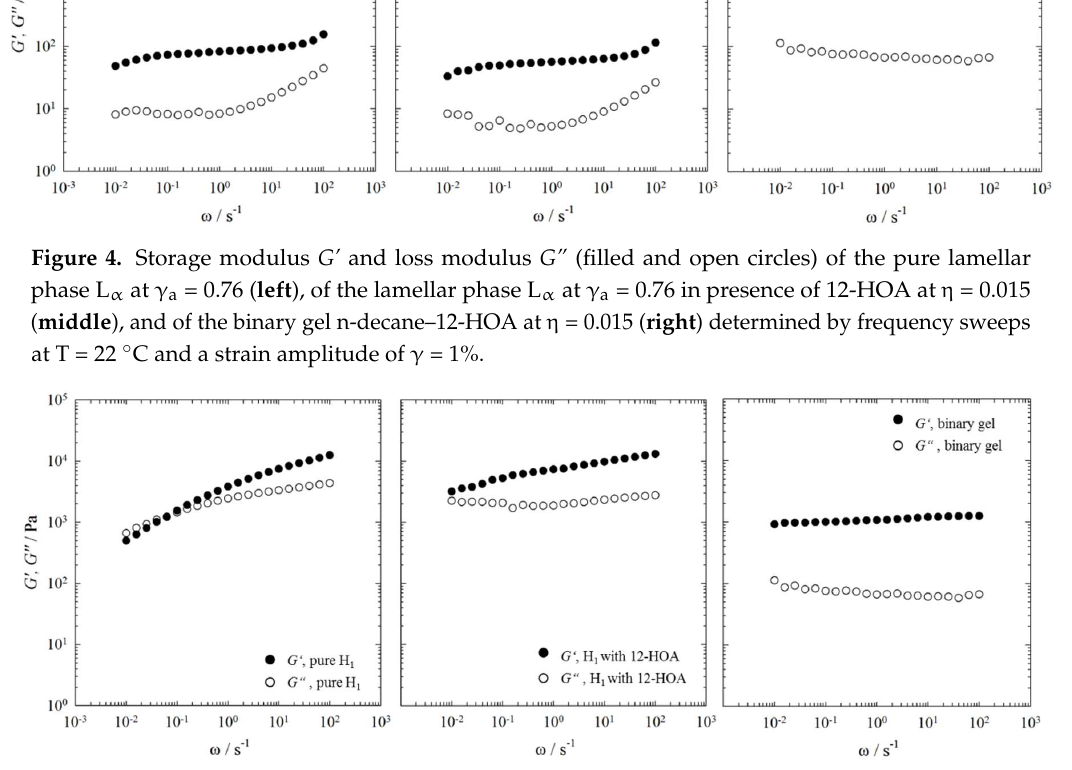
Figure 5. Storage modulus G’ and loss modulus G” (filled and open circles) of the pure hexagonal phase H 1 at γ a = 0.50 ( left ), of the hexagonal phase H 1 at γ a = 0.50 in presence of 12-HOA at η = 0.015 ( middle ), and of the binary gel n-decane–12-HOA at η = 0.015 ( right ) determined by frequency sweeps at T = 22 °C and a strain amplitude of γ = 1%.